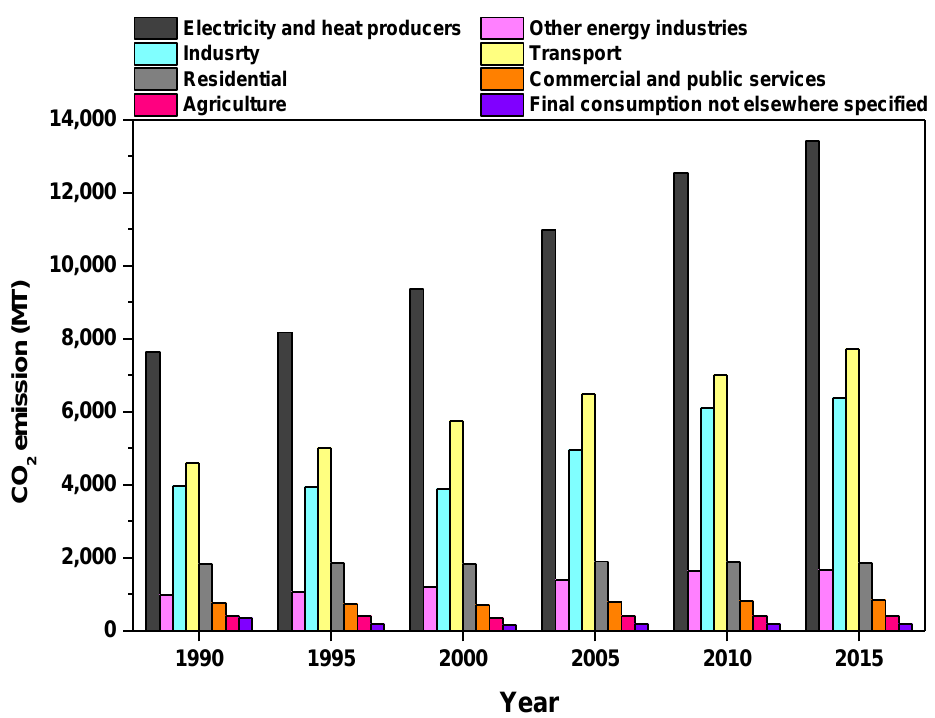
Figure 1. Global CO 2 emissions by sector [2]; 2018, IEA.